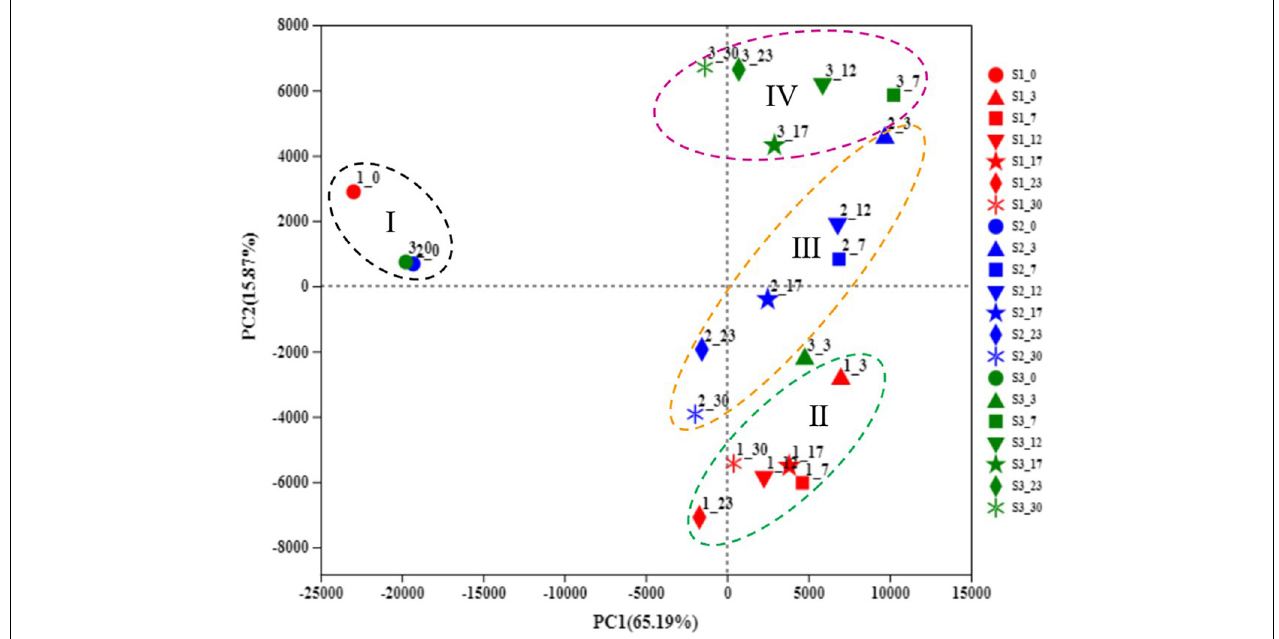
FIGURE 3 | Principal component analysis (PCA) of microbial communities during traditional northeast sauerkraut fermentation from different households. S1, S2, and S3 represented three different households. The number behind “ − ” (0, 3, 7, 12, 17, 23, 30) represented fermentation time (day). Group I represented all samples at day 0. Groups II, III, and IV represented samples at days 3, 7, 12, 17, 23, 30 from #1, #2, and #3 household, respectively.